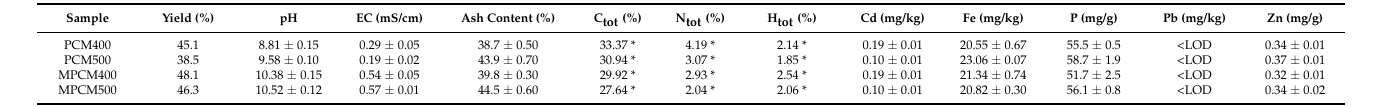
Table 2. Physico-chemical characteristics of PCM400, PCM500, MPCM400 and MPCM500 (average value ±